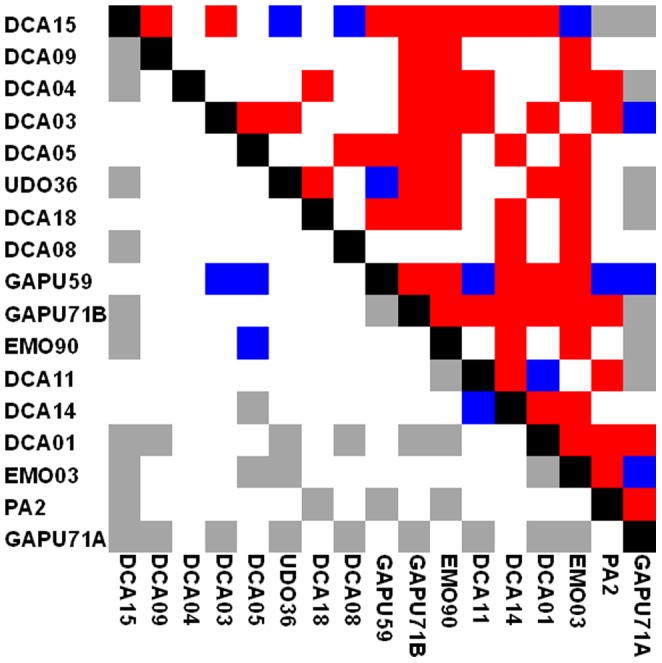
Linkage disequilibrium p-values between pairs of 17 SSR loci.Linkage disequilibrium p-values obtained for the 457 genotypes (distinguished by more than three dissimilar alleles, upper triangle) and for the CC94 core collection (lower triangle) using the Tassel program. Red, blue, grey and white boxes indicate high (p<0.0001), intermediate (0.01>p>0.0001), low significance (p>0.01) and no significance, respectively. A sampling effect on the linkage disequilibrium was found between pairs of SSR loci.